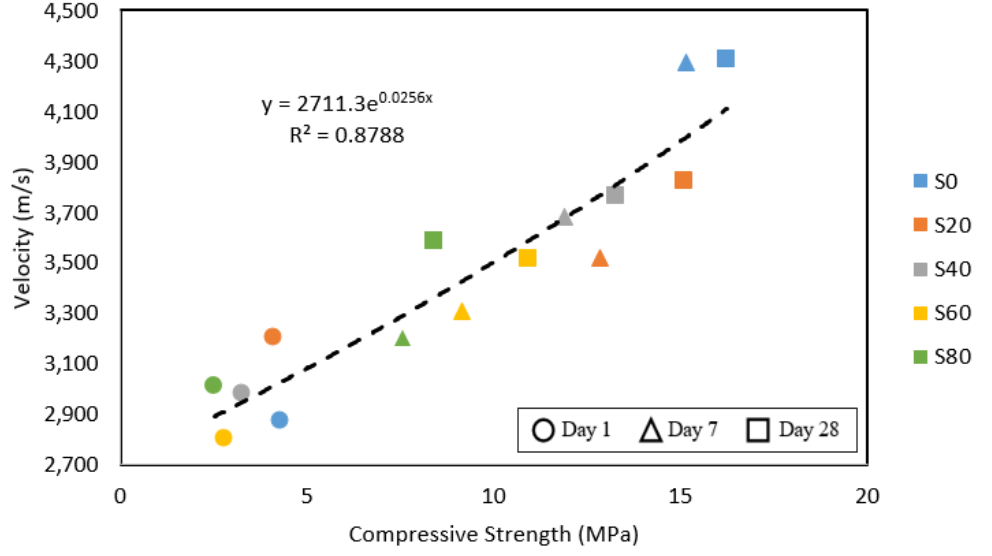
Figure 6. Correlation between P-wave velocity and the concrete compressive strength of all mix proportions on day-1, day-7 and day-28 maturity ages